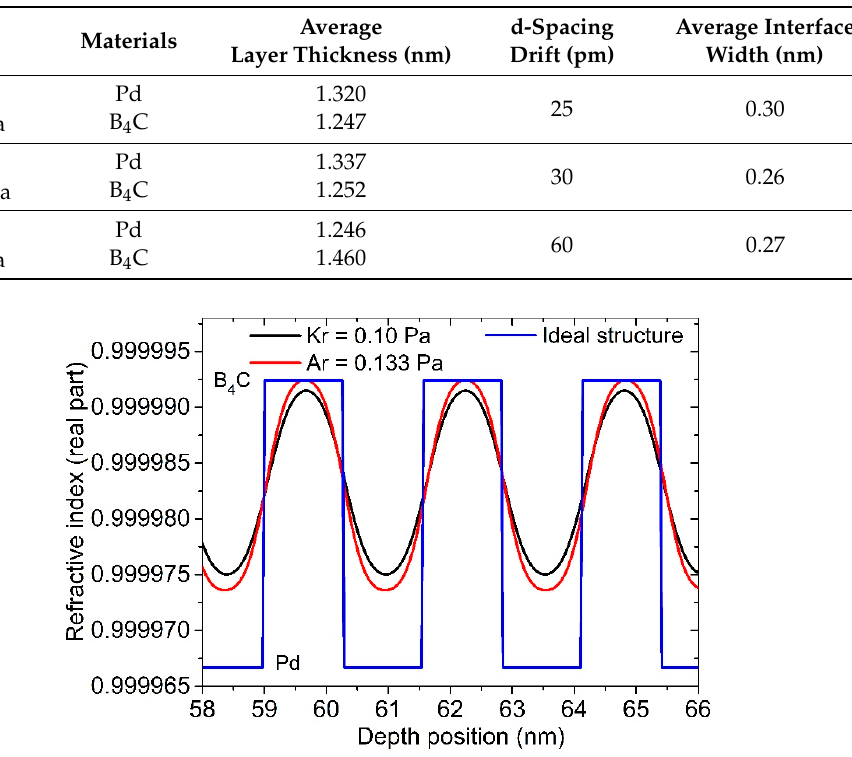
Figure 2. Reconstructed refractive index profiles of the multilayers sputtered by Kr and